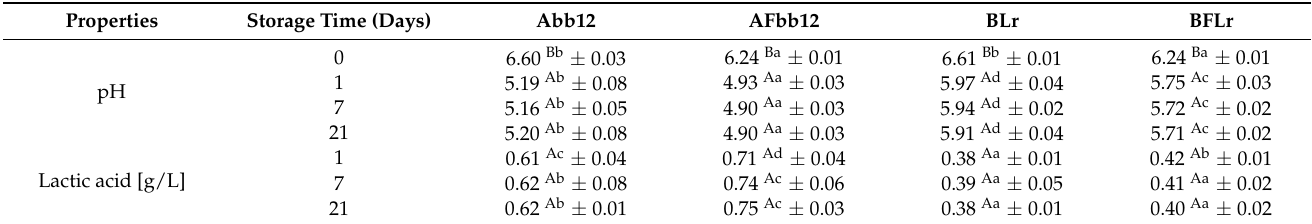
Table 2. Lactic acid content and pH value of ice creams during